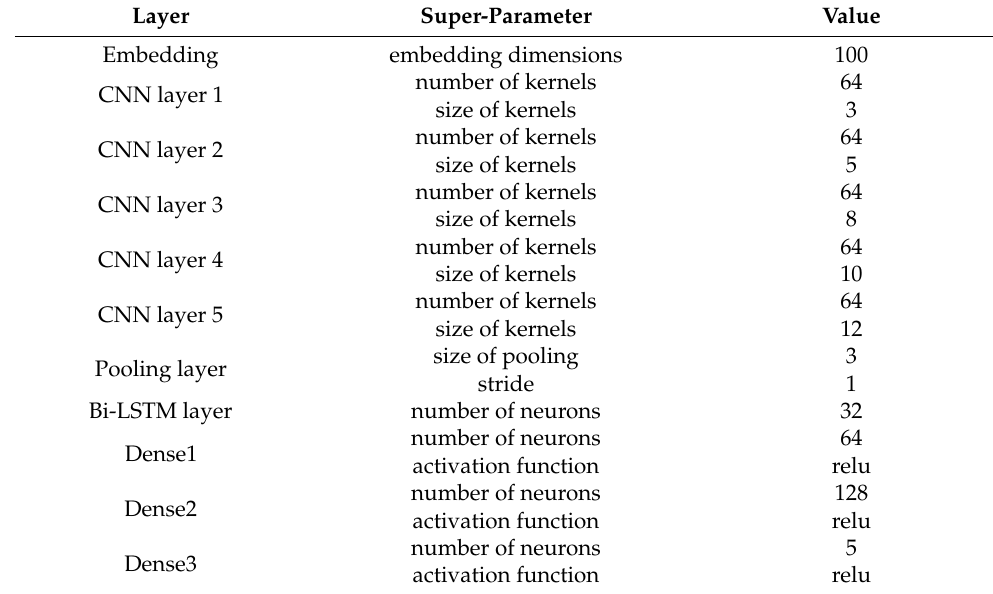
Figure 1. The predictive accuracy of various hyper-parameters. ( A ) ED, ( B ) LR, ( C ) DP, and ( D ) PS denote embedding dimension in the embedding layer, the learning rate, the dropout rate, and the pooling size in the pooling layer, respectively. Table 1. The details of hyper-parameters in the MPMABP.